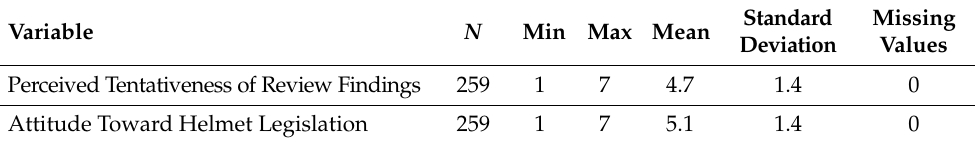
Table 2. Descriptive statistics for outcome